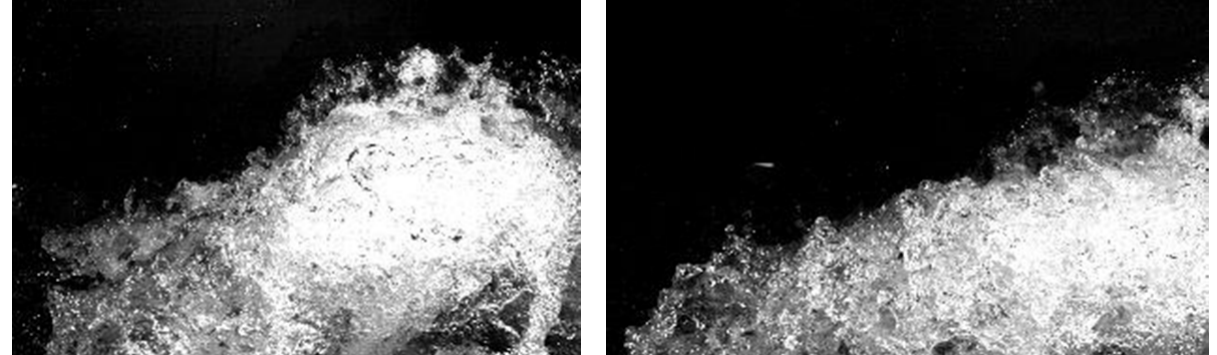
Figure 18. Frame shot on camera 1 (left) and camera 2 (right)